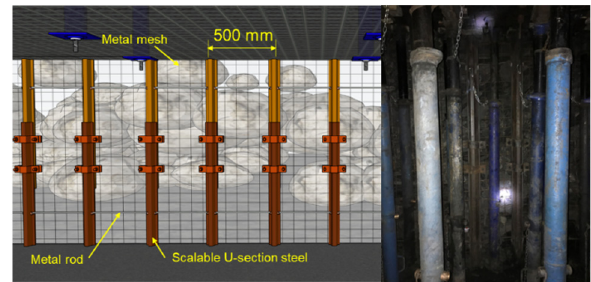
Figure 14. Schematic diagram of gangue protection system.